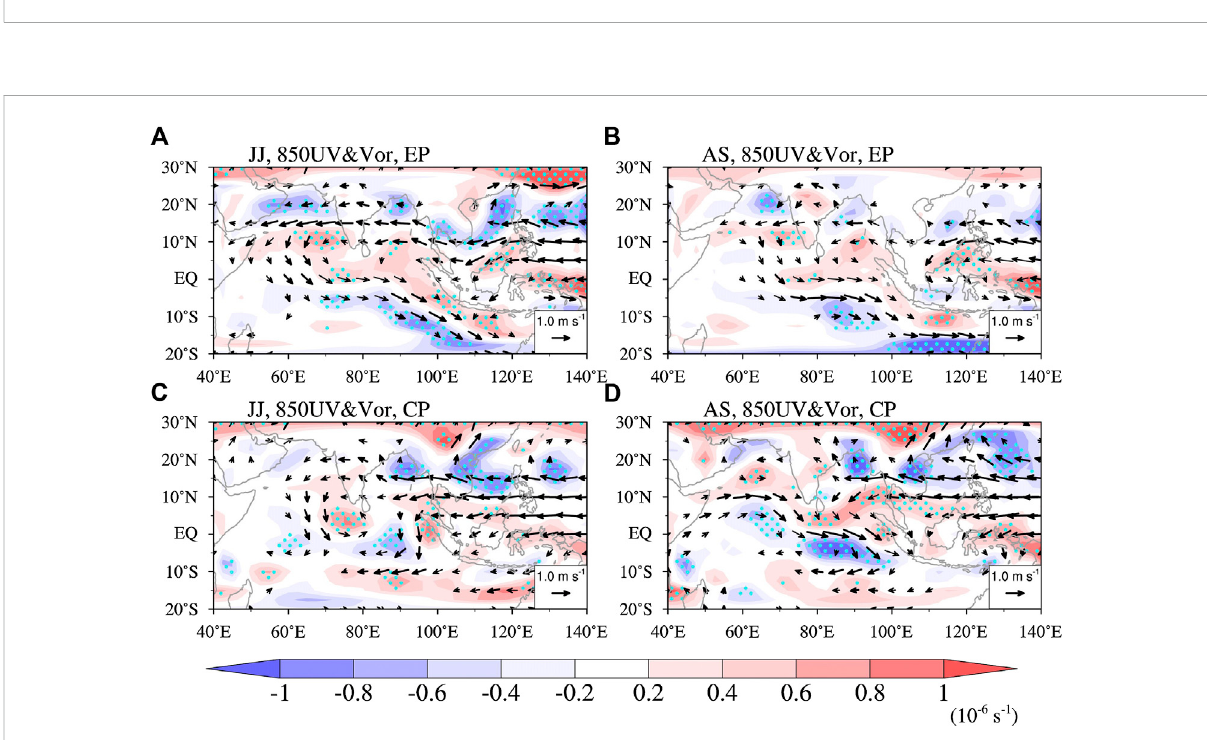
FIGURE 3 (A) June – July (JJ) and (B) August – September (AS) mean wind anomalies at 850 hPa (vectors; units: m s − 1 ) and their related relative vorticity anomalies(shading;units:10 − 6 s − 1 )fordecaying EPElNiñoevents. (C) and (D) arethesameas (A) and (B)